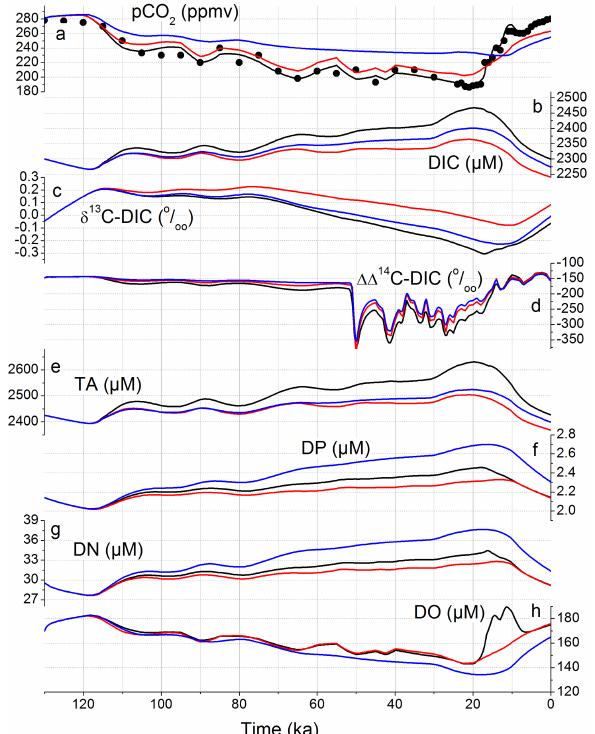
Figure 5. Model results for the standard case (simulation STD, black lines), for constant circulation (simulation STD-CC, red lines), and constant circulation and nutrient utilization (simulation STD-CC-CN, blue lines). (a) Atmospheric p CO 2 , dots indicate ice-core data (Monnin et al., 2001; Petit et al., 1999; Monnin et al., 2004); (b–h) global mean seawater concentrations and isotopic compositions: (b) dissolved inorganic carbon (DIC); (c) δ 13 C of DIC; (d) difference between radiocarbon in seawater DIC and at- mospheric CO 2 ( (cid:49)(cid:49) 14 C-DIC = (cid:49) 14 C-DIC- (cid:49) 14 C-CO 2 ); (e) total alkalinity (TA); (f) dissolved phosphorus (DP); (g) dissolved reac- tive nitrogen (DN); (h) dissolved oxygen